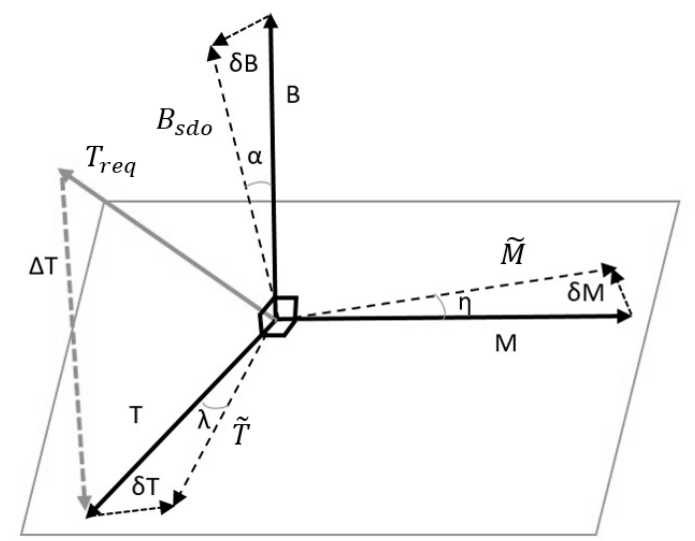
Figure 3. The desired T req and the projected T torques for a given B